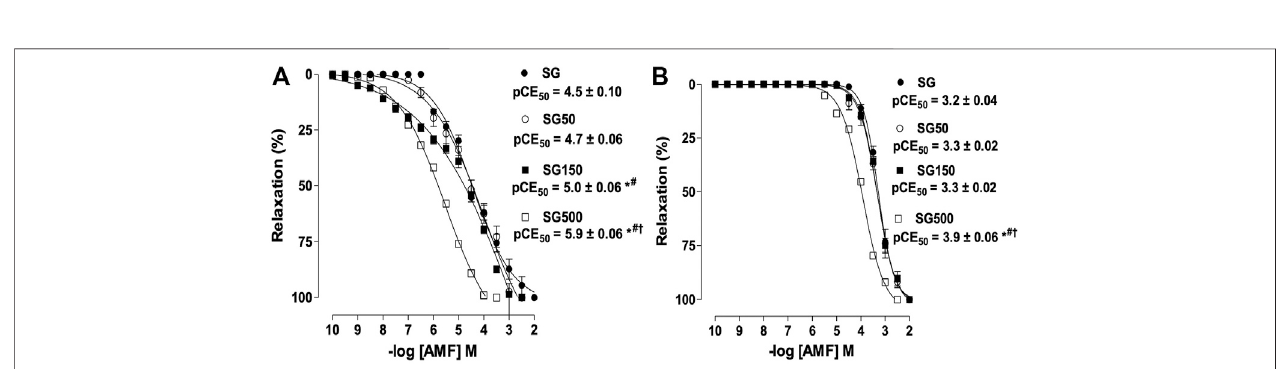
FIGURE 2 | The relaxant effect of AMF on the tonic contractions induced by CCh in SG ( C ), SG50 ( ○ ), SG150 ( ■ ) and SG500 groups (.) in rat trachea in the presence (A) and absence of epithelium (B) . The symbols and vertical bars represent the mean and S.E.M., respectively (n = 5). One-way ANOVA followed by Bonferroni ’ spost-test.* p < 0.05(SG vs. SG150 andSG500), # p < 0.05(SG50 vs. SG150 and SG500)and † p < 0.01 (SG150 vs. SG500).AMF =aminophylline.Healthy saline group = SG. Healthy group supplemented with S. platensis at 50, 150 and 500 mg/kg = SG50, SG150 and SG500, respectively.